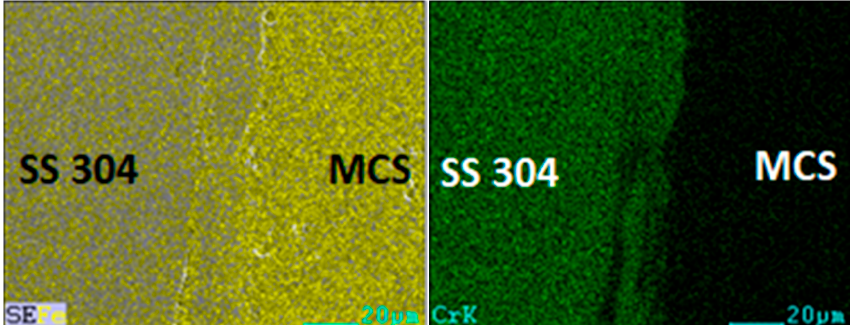
Figure 8. EDS element (Fe and Cr) mapping at the joint of medium-carbon steel–304 SS.